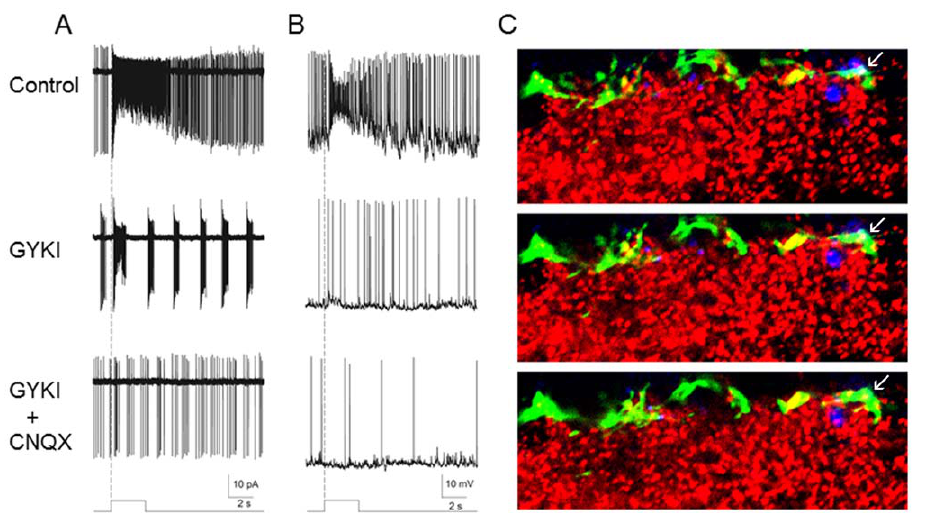
Figure 2. AMPA receptor mediation of synaptic transmission from melanopsin ganglion cells to dopamine amacrine cells in rd1 rod/ cone degenerate mouse retinas. Loose patch (A, n=5) and whole cell (B, n=3) recordings from dopamine amacrine cells showing substantial but incomplete blockade of light responses driven by melanopsin ganglion cells by application of the specific AMPA receptor blocker GYKI-52466 (200 m M, middle trace) and then complete block by co-application of the AMPA/kainite receptor blacker CNQX (100 m M, bottom). Stimulus bar shows the timing of the light pulse (470 nm, 3 s, 1.3 6 10 13 photons cm 2 2 s 2 1 ), with the dashed vertical line showing light onset. (C) Confocal immunofluorescence of serial 0.5 m m optical sections of the retinal inner plexiform layer of a WT mouse showing TH staining for dopamine neuron processes (green), melanopsin staining for melanopsin ganglion cell processes (blue) and pan-AMPA receptor staining for AMPA receptor subunits GluR1–4 (red). AMPA receptors are present on dopamine cell processes (yellow), including at the apposition of melanopsin processes and dopamine cell processes (arrows).